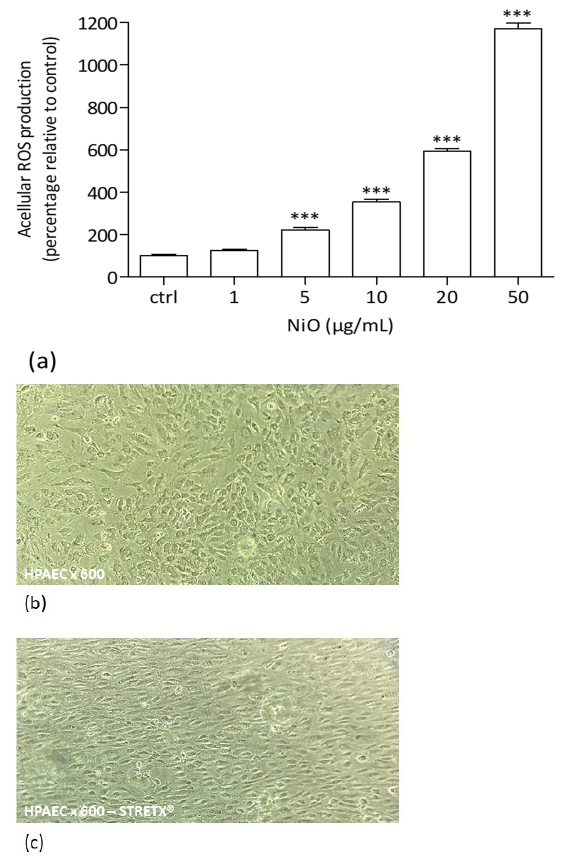
Figure 1. ( a ) Acellular NiONP ROS production measured by spectrofluorimetry with the H2DCF- DA probe. The results were expressed as the H2DCF probe fluorescence intensity relative to controls (medium without NiONPs). *** p < 0.001 vs. control according to Kruskal–Wallis test followed by a Dunn’s multiple comparison test. ( b , c ) HPAEC after 20 h of culture, either under physiological or pathological conditions, observed by phase contrast microscopy (PCM) at 600× magnification. ( b ) Untreated cells under static conditions in normoxia. ( c ) Untreated cells under 20% CS in